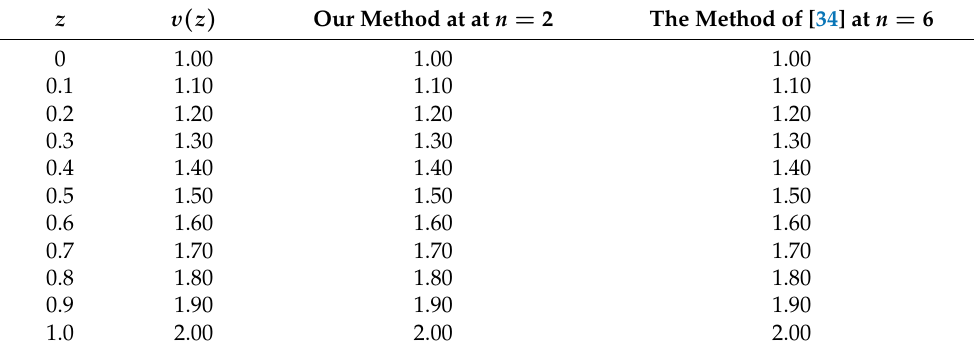
Table 4. Comparison of approximate solution of Example